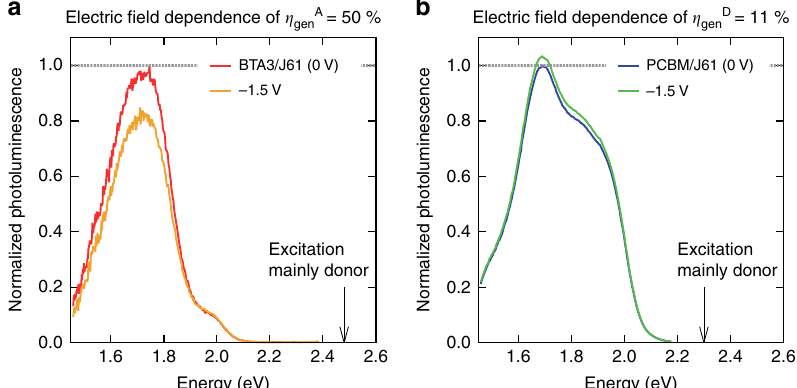
Fig. 5 Electric fi eld dependence of charge generation. The electric fi eld dependence is de fi ned as the ratio of the charge generation ef fi ciency with an applied bias of 0 V (i.e., short circuit) to − 1.0 V. Electric fi eld dependence plotted against a , E g opt − E CT and b , E CS − E CT a